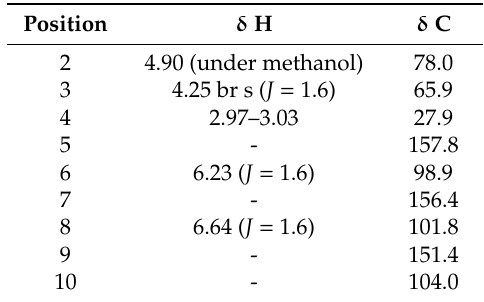
Table 6. NMR assignments for Epicatechin-7- O